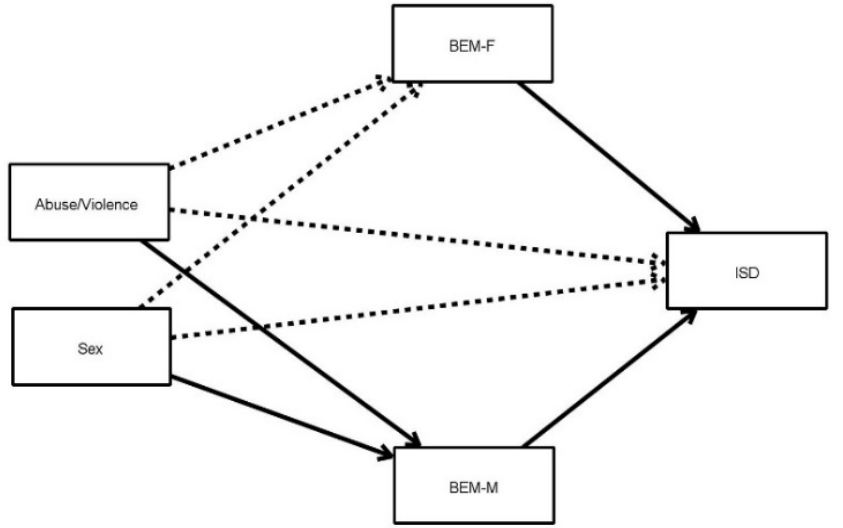
Figure 1. Mediational model. Categorical independent variables (factors) are shown with only one rectangle, but their effect is estimated using contrast variables. BEM-M = Male behaviors, BEM-F = Female behaviors; ISD = Inhibited sexual desire.